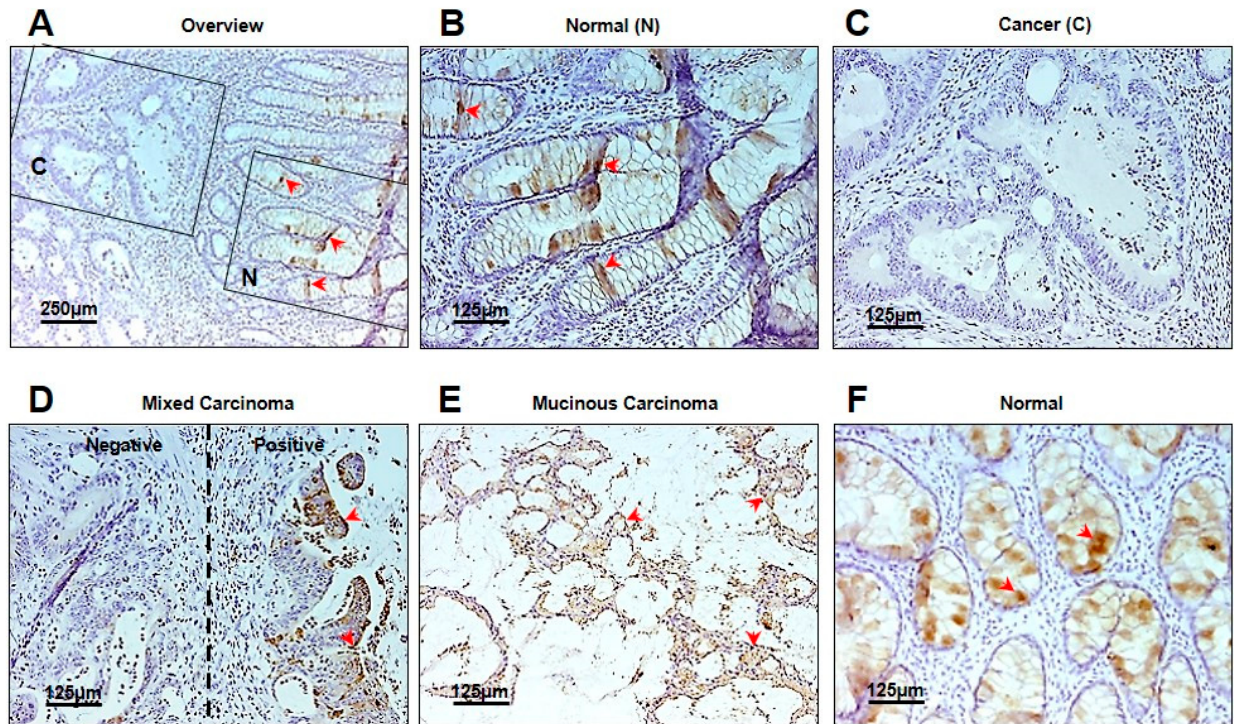
Figure 5. Immunohistochemical analysis of TFF1 expression in normal mucosa and in CRC tissue. ( A ) Overview of an area containing normal mucosa (N) and the adjacent cancer tissue (C). Arrows mark TFF1-positive goblet cells; ( B ) localization of TFF1 in goblet cells of normal mucosa (N) (arrows); ( C ) loss of TFF1 expression in adjacent cancer ( C ) tissue; ( D ) a mixed pattern of carcinoma tissue staining with both positive (arrows) and negative areas; ( E ) a mucinous carcinoma area positive for TFF1 staining (arrows); ( F ) normal mucosa stained for TFF1 in goblet cells (arrows).